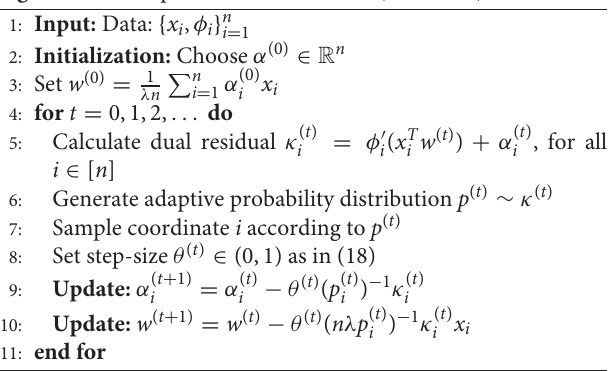
Algorithm 1 Adaptive Dual Free SDCA